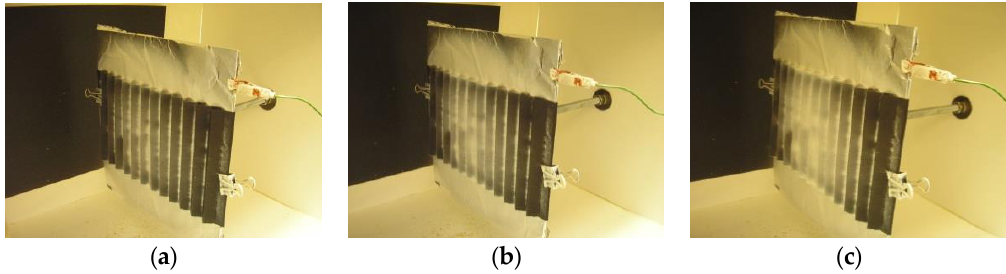
Figure 4. Photographs of 1 × 1 cm V-shaped collector showing collected nanofibers after: ( a ) 15 min, ( b ) 30 min, and ( c ) 1 h of electrospinning.